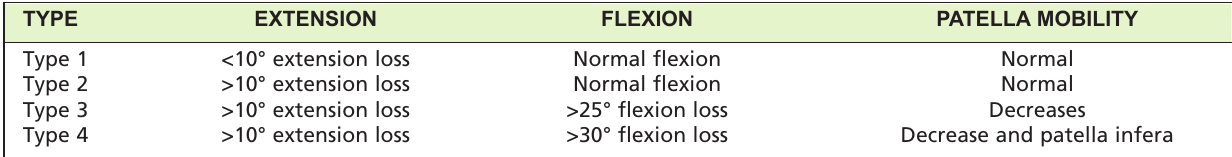
Classification of arthrofibrosis Table I: